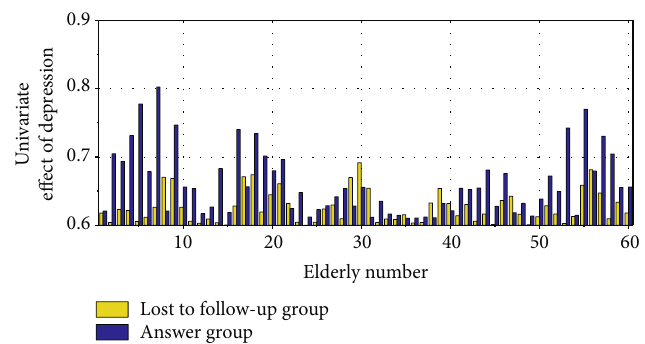
Figure 4: Univariate analysis of depression. Table 3: Multivariate logistic regression analysis of depression among the elderly in the community. Physical illness in the past six months